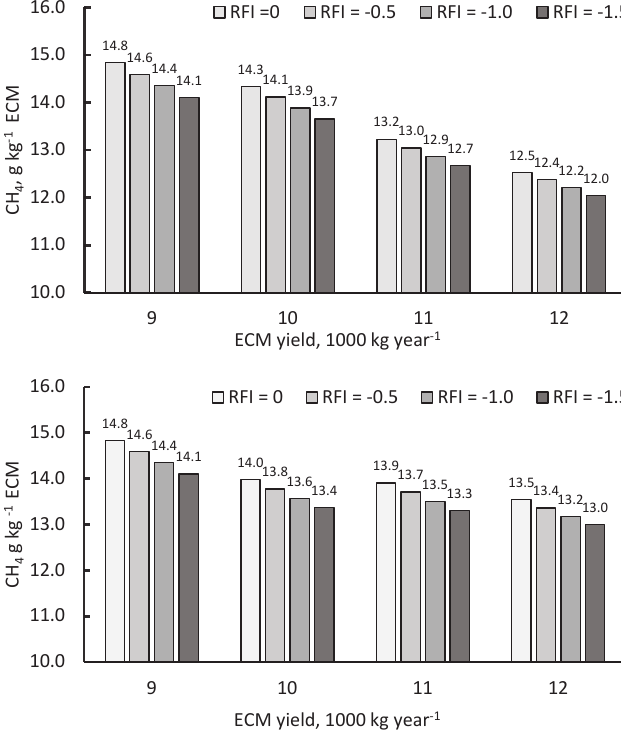
Fig. 6. The effects of increased ECM yield and residual ECM (RECM) on methane intensity (kg CH kg -1 ECM) when ECM yield increased without (above) and with 4 (below) associated changes in BW (30 kg per 1000 kg ECM).